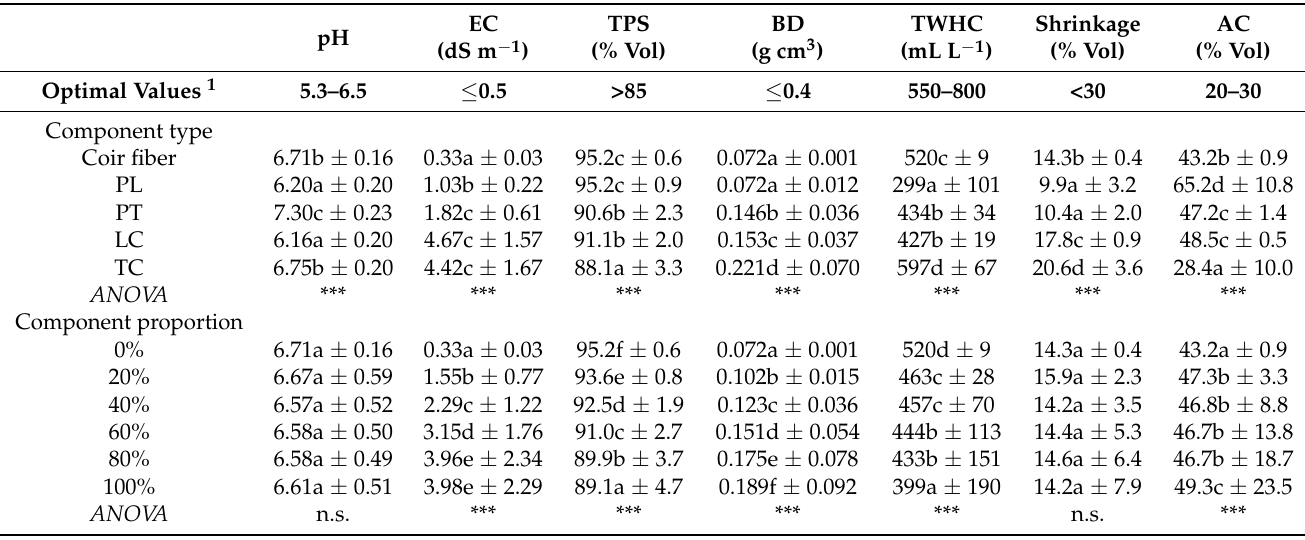
Table 2. Effect of the type and proportion of the organic materials considered for the principal physico-chemical and physical parameters of the growing